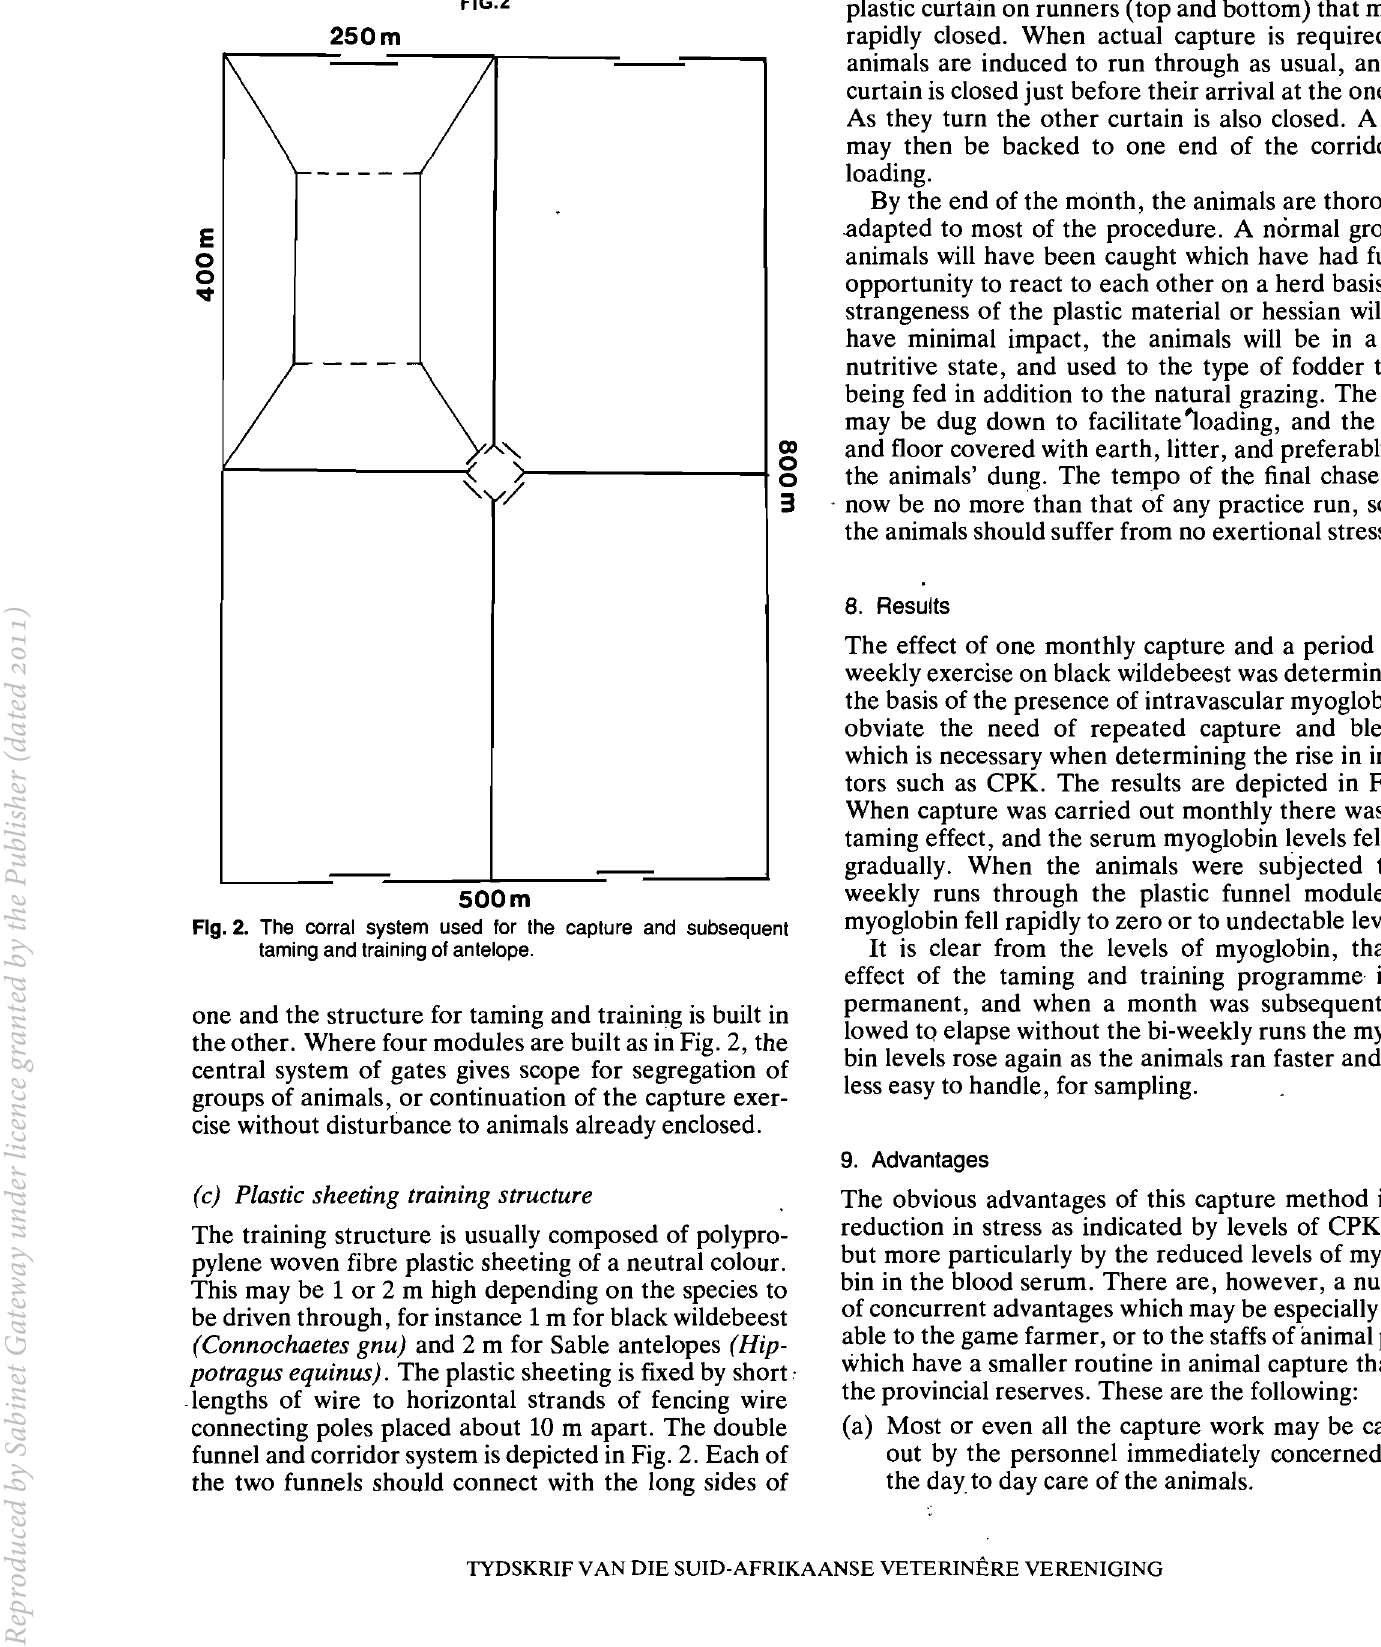
Fig. 2. The corral system used for the capture and subsequent taming and training of antelope. one and the structure for taming and training is built in the other. Where four modules are built as in Fig. 2, the central system of gates gives scope for segregation of groups of animals, or continuation of the capture exer cise without disturbance to animals already